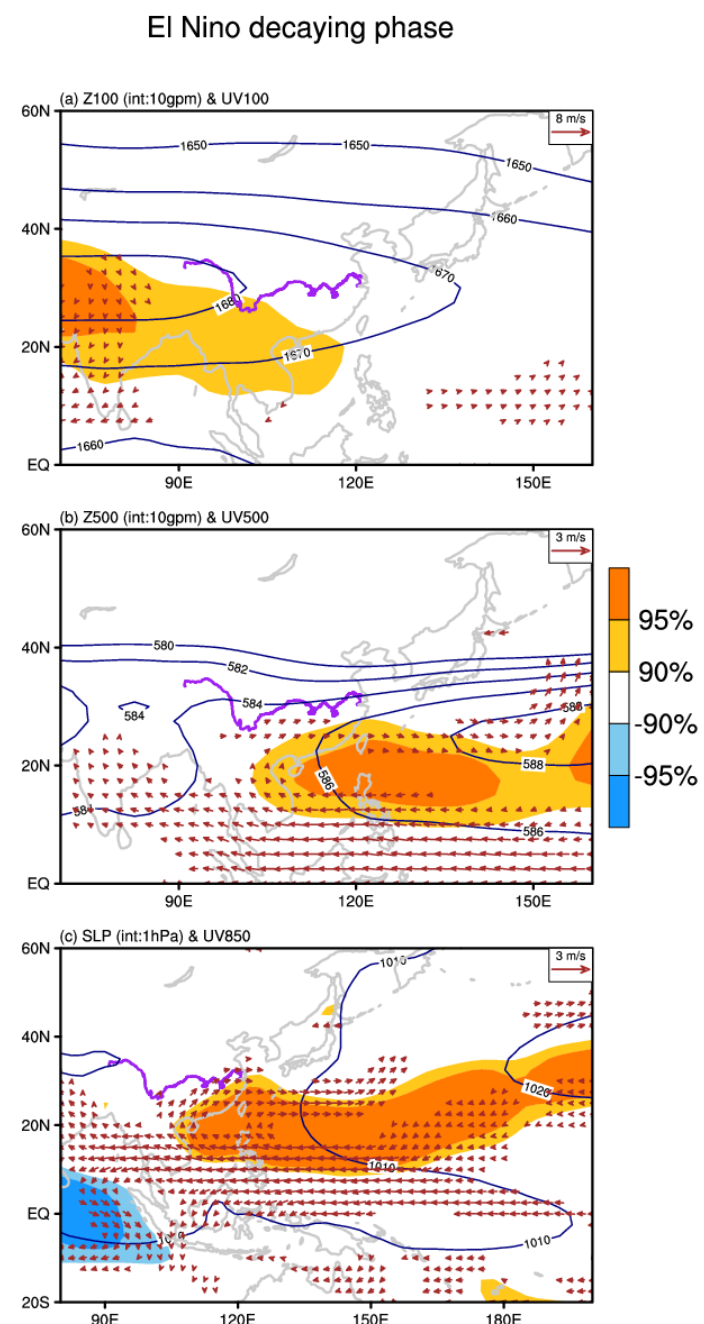
Figure 8. Same as Figure 7, but for the El Niño decaying